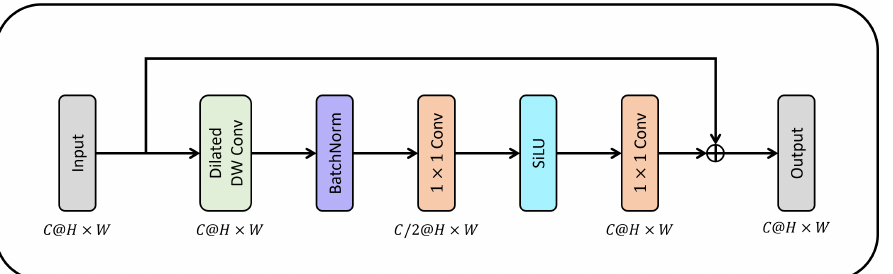
Figure 6. Structure of the proposed lightweight spatial module. The proposed LSM used kernel size 5 and dilated rate 2. BatchNorm (BN): batch normalization; dilated DW: dilated depth-wise Conv; H × W : (H: height, W: width) input feature map size; SiLU: sigmoid linear unit; ( + ): elemental wise sum.